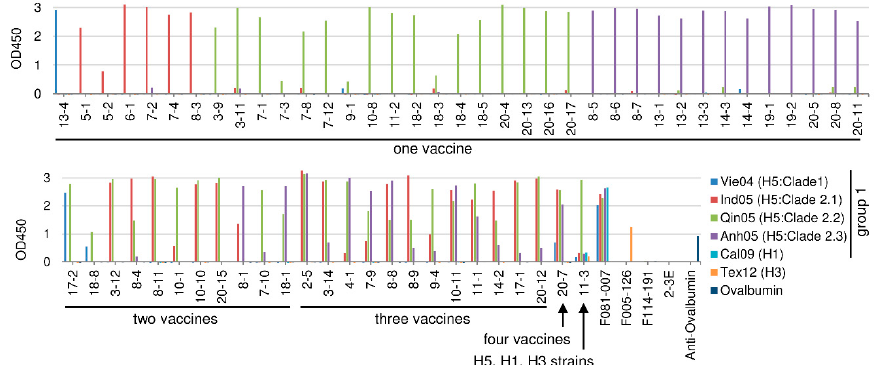
Figure 1. Binding activity of HI-positive clones. The binding activity of Fab-PP (produced from sixty-two clones) to vaccines of four H5N1, H1N1, and H3N2 strains was examined by ELISA. Clones F081-007 (anti-H1 and -H5 HA (hemagglutinin) antibody) and F005-126 (anti-H3 HA antibody) were used as positive controls. Clone 2-3E (anti-rotavirus antibody) was used as a negative control. The binding activity is shown as the optical density at 450 nm (OD450).